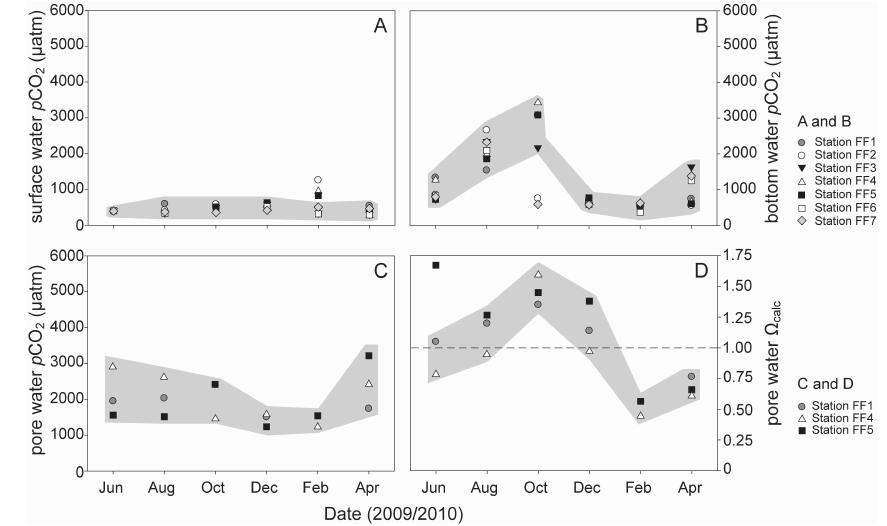
Fig. 2. ( A and B ) surface water, near-bottom water, and bottom water p CO 2 at sampling stations from FF1 to FF7; ( C and D ) sediment pore water p CO 2 and (cid:127) calc at stations FF1, FF4 and FF5 from June 2009 to April 2010.